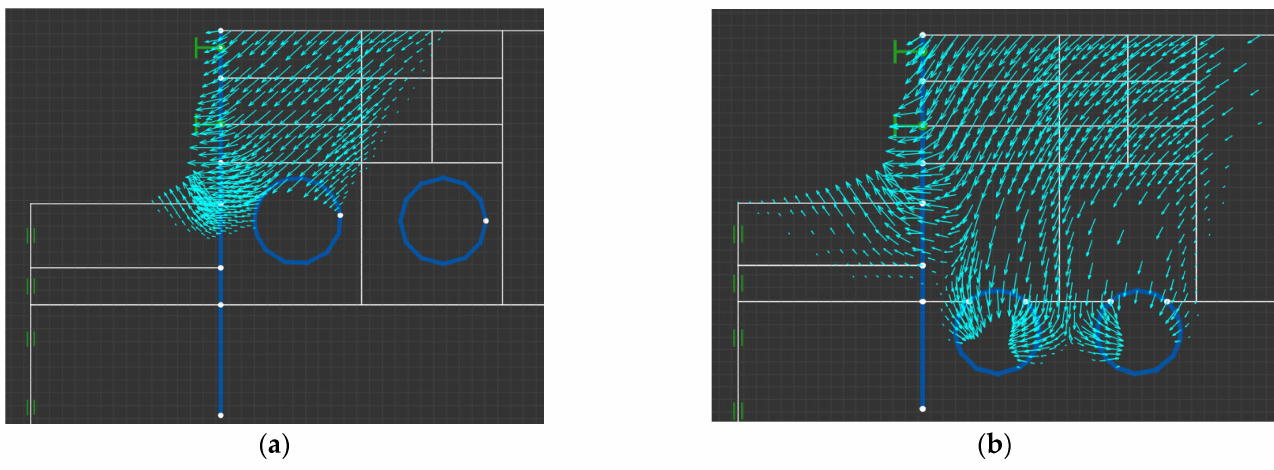
Figure 21. Incremental displacement vector under different cover depth C of the twin shield tunnels in stage (3): ( a ) C = 0.5 H and ( b ) C = 1.0